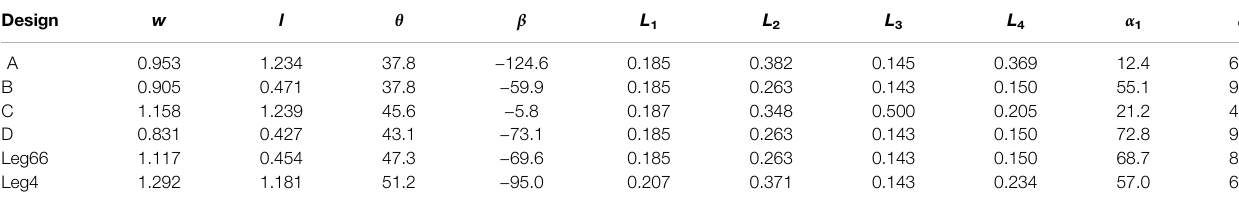
TABLE4| Kinematicvaluesforthelabeleddesignsin Figures9 , 10 .Lengthsareinmeters,andanglesareindegrees.Leg66andLeg4areusedforhardwareexperimentsin Section 5 . Design